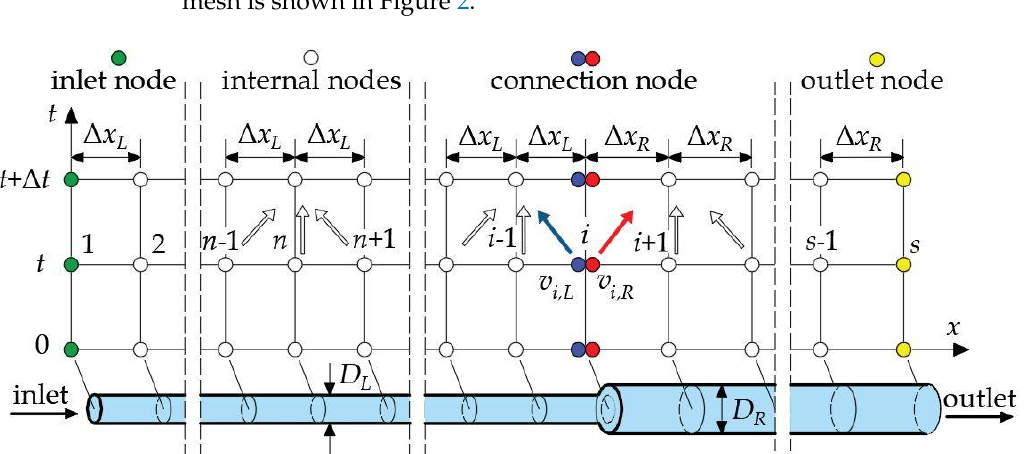
Figure 2. Numerical grid for the MacCormack explicit